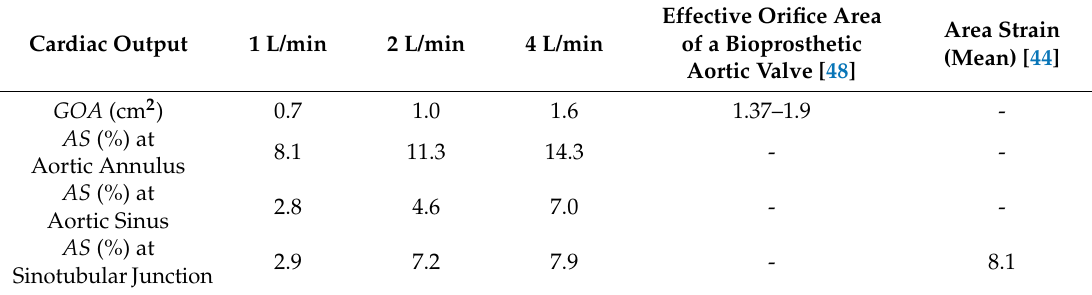
Table 2. Area strain ( AS ) and maximum geometric orifice area ( GOA )